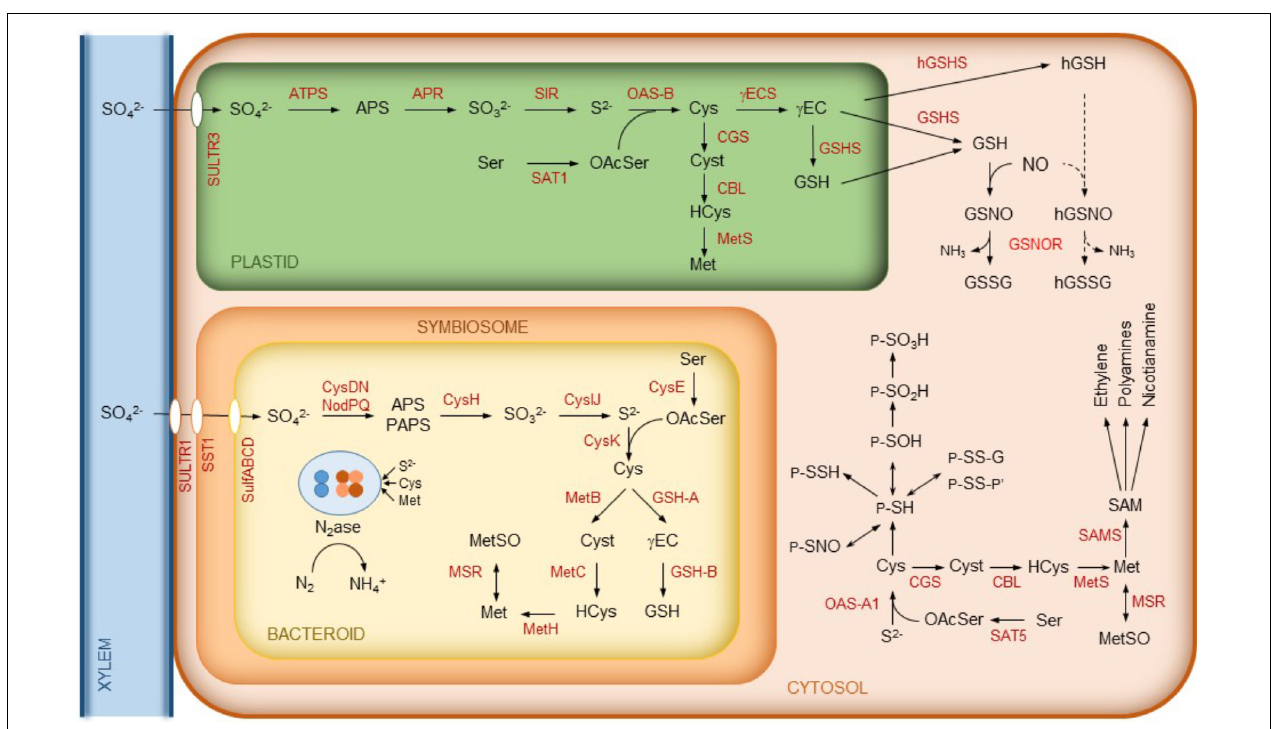
FIGURE 2 | Schematics of sulfur metabolism in legume nodules. In the cytosol, some common reactions affecting the thiol group of Cys residues of proteins (P) are indicated. These include sulfenylation (P-SOH), sulfinylation (P-SO 2 H), sulfonylation (P-SO 3 H), persulfidation (P-S-SH), S -nitrosylation (P-SNO), glutathionylation (P-S-S-G, where G is a glutathione molecule linked to a protein Cys residue through its thiol group), and formation of mixed disulfides (P-S-S-P’, where P and P’ may be identical or different proteins). Note that sulfenylation, glutathionylation, and formation of mixed disulfide are reversible, whereas sulfinylation may be irreversible and sulfonylation is irreversible. For simplicity, we omit reactions such as Cys synthesis that may also occur in the mitochondria. Abbreviations are as indicated in Table 1 . Cyst, cystathionine; (h)GSSG, (homo)glutathione disulfide; HCys, homocysteine; MetSO, methionine sulfoxide; OAcSer, O